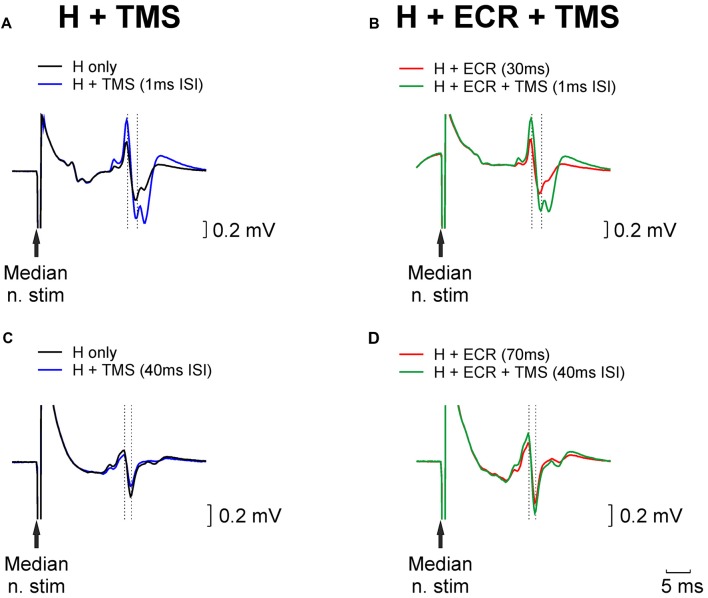
Examples of H reflex conditioning. (A) Black trace illustrates an unconditioned H reflex. Blue trace shows the H reflex conditioned by TMS delivered 1 ms before the median nerve stimulus; a clear facilitation is evident. (B) Red trace shows the H reflex conditioned by extensor carpi radialis (ECR) stimulation 30 ms before the median nerve stimulus. This facilitated the reflex; the median nerve intensity was reduced until the reflex amplitude approximately matched the unconditioned reflex (black trace, Panel A). Green trace illustrates the effect of conditioning this reflex with TMS (same timing relative to median nerve as in Panel A). (C,D) As for (A,B), but now illustrating ECR stimulation delivered 70 ms before the median nerve stimulus, which produced a reflex suppression, necessitating an increase in stimulus intensity to match the reflex amplitude. TMS in (C,D), was delivered 40 ms before the median nerve stimulus.